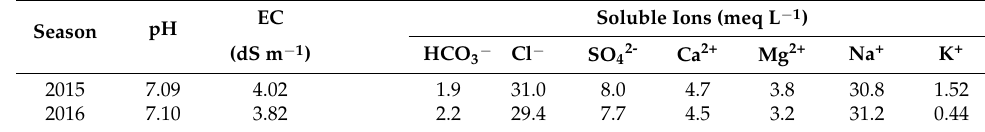
Table 3. Chemical properties of the irrigation water during the 2015 and 2016 seasons.